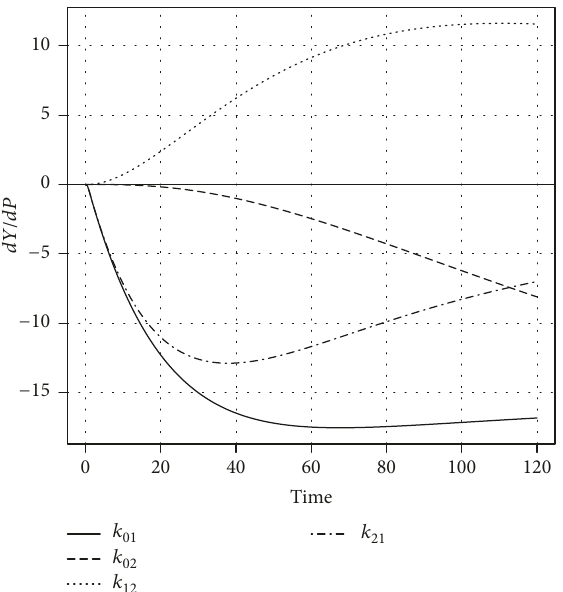
Figure 1: Time course of model output sensitivities with respect to